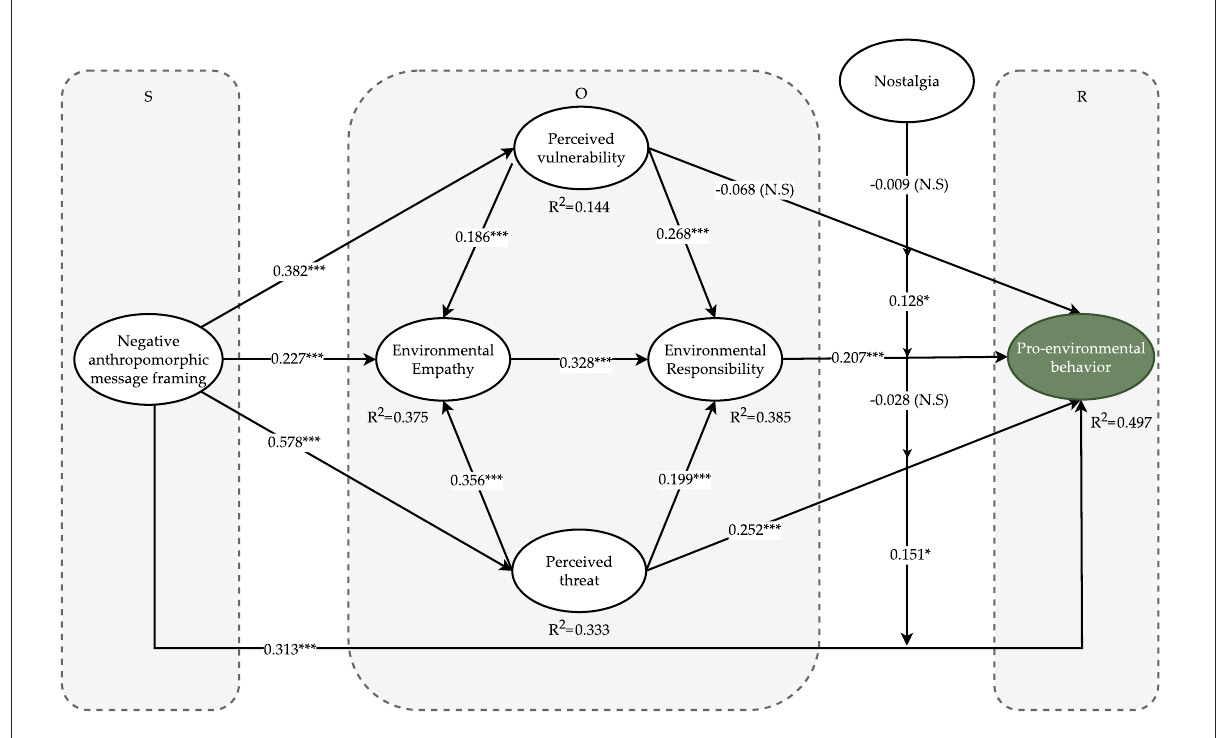
FIGURE2 Inner model results. *** p -value < 0.001, ** p -value < 0.01, and * p -value < 0.05.